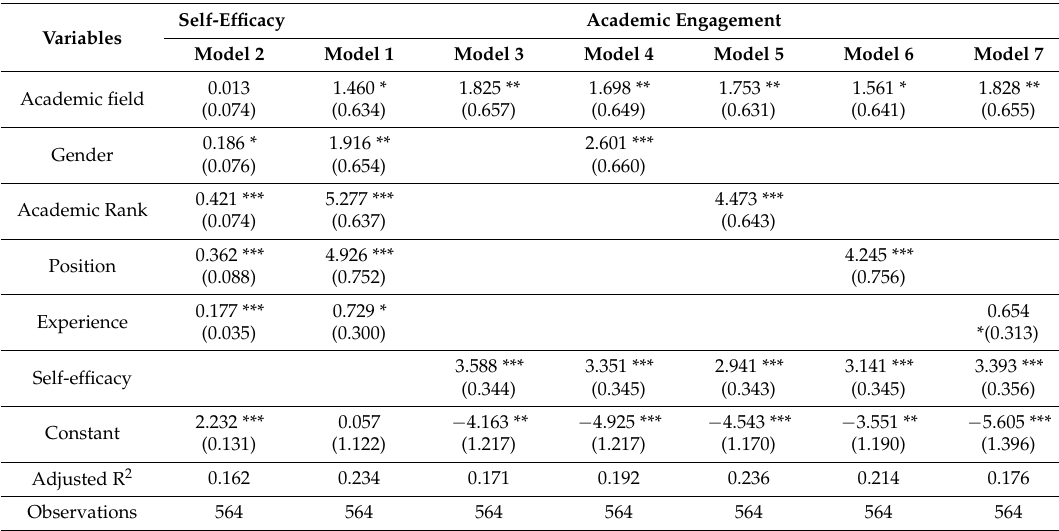
Table 4. Regression results. Dependent variables: self-efficacy and academic engagement